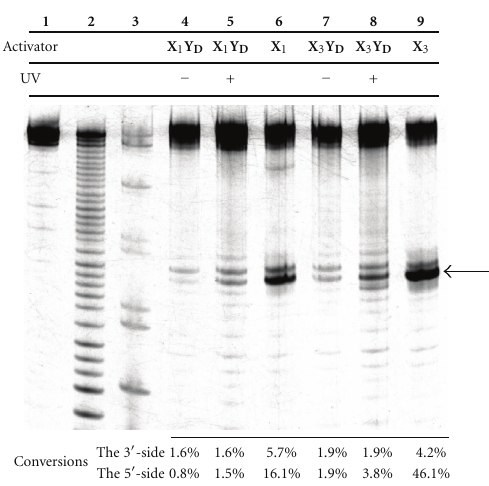
Figure 5: A denaturing 20% PAGE pattern for site-selective scission of 1 activated by 2 , 3 , 8 , or 10 . Lane 1, control reaction in a bu ff er solution; lane 2, treatment with Lu(III) alone; lane 3, RNase T1 digestion; lane 4, 2 and Lu(III) without UV irradiation; lane 5, 2 and Lu(III) with UV irradiation; lane 6, 3 and Lu(III) without UV irradiation; lane 7, 8 and Lu(III) without UV irradiation; lane 8, 8 and Lu(III) with UV irradiation; lane 9, 10 and Lu(III) without UV irradiation. The 5 (cid:2) -side cleavage of U-19 is indicated by the arrow. Conversions of each scission are presented in the bottom. Reaction conditions; [RNA] = 5 μ M, [DNA] = 10 μ M, [LuCl 3 ] = 100 μ M, [Tris] = 10mM, [NaCl] = 200mM, pH 7.5, 37 ◦ C, 4